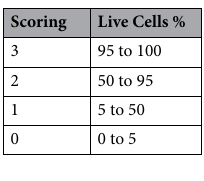
Table 4. Scoring system for the evaluation of the cytocompatibility test in